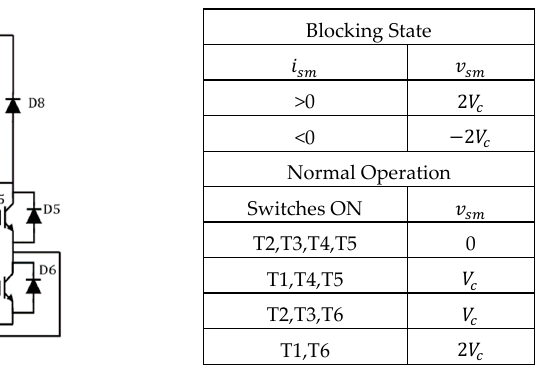
Figure 13. ACTSM